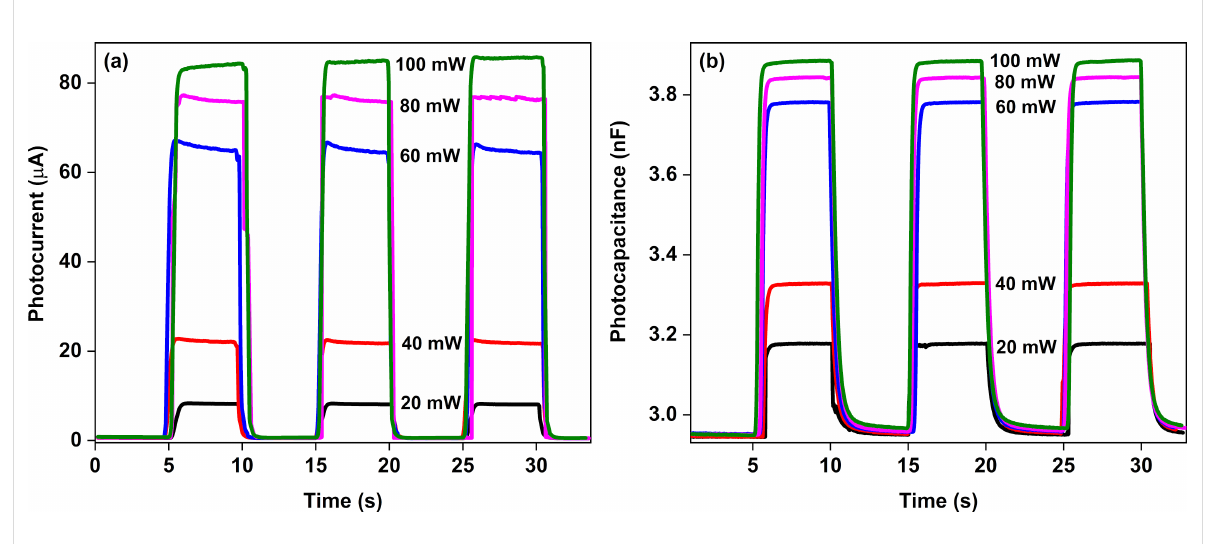
factor values increase and barrier height values decrease with increasing light power. The device exhibited good rectifying be- havior as well as good photodiode properties at reverse biases. The C – V characteristics of the Au/CuNiCoS 4 /p-Si photodiode revealed that the capacitance values as well as other electrical parameters extracted from C − 2 – V plots strongly changed depending on frequency and voltage. The results show that the fabricated Au/CuNiCoS 4 /p-Si photodiode can be used in opto- electronic applications and has the potential to open new oppor- tunities for improving the device